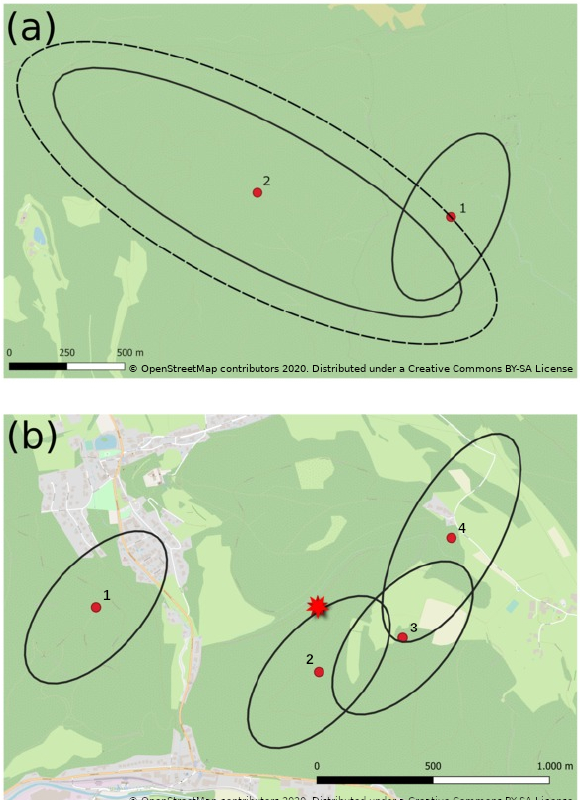
Figure 1. (a) Example of a two-stroke flash. The original error ellipses are displayed (solid) alongside the scaled error ellipse of stroke 2 (dashed) as used by A2. (b) A flash with a multiplicity of 4. The star denotes the average position of all four